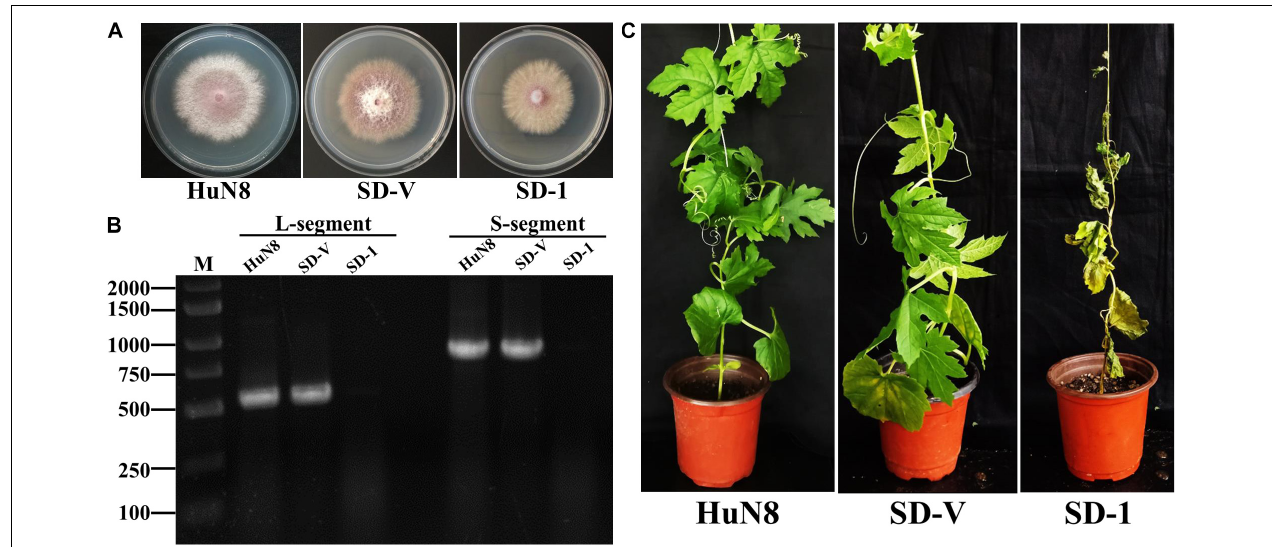
FIGURE 6 | FoOuLV1 infectivity and pathogenicity in FoM strains. (A) Colony morphology of the HuN8 strain, the virulent strain SD-1, and the derivative strain SD-V (cultured on PDA for 2 days at 28 ◦ C). (B) Detection of the L- and S-segments by RT-PCR. M, DNA marker. (C) Pathogenicity detection in a living bitter gourd